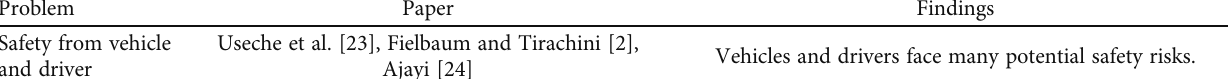
Table 1: Ride-hailing travel safety.